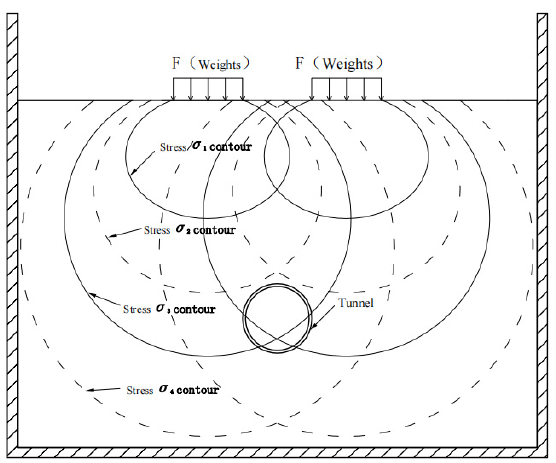
Figure 23. Stress σ contour of wet sand at surcharge on two sides.